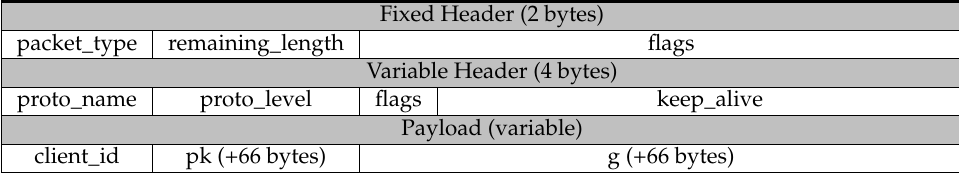
Table 1. MQTT modified connection packet.